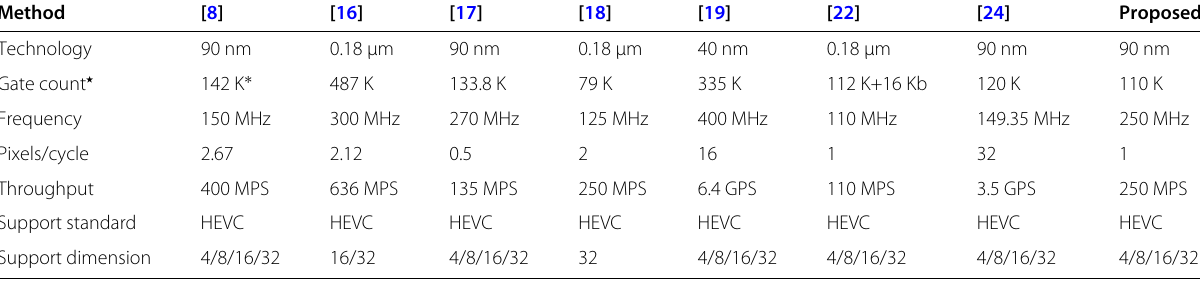
Table 2 Comparison of inverse 2-D transform cores